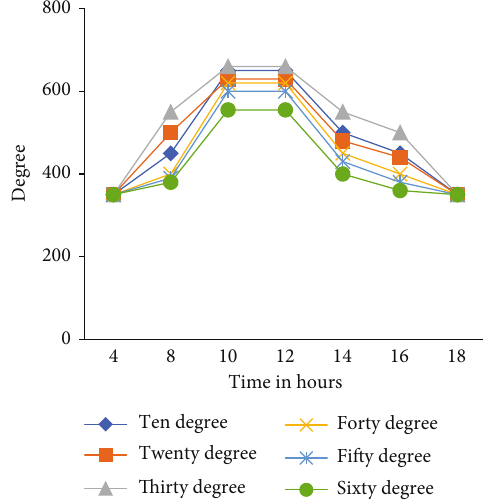
Figure 11: Absorption variance of solar radiation in various